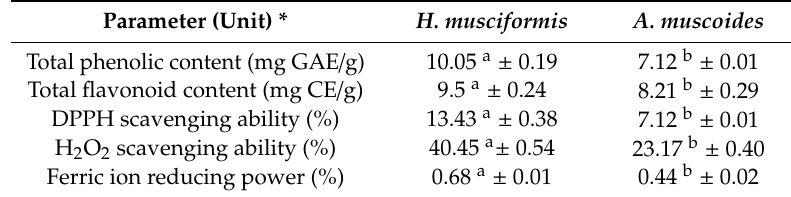
Table 1. Total phenolic content and antioxidant activity of Hypnea musciformis and Acanthophora muscoides